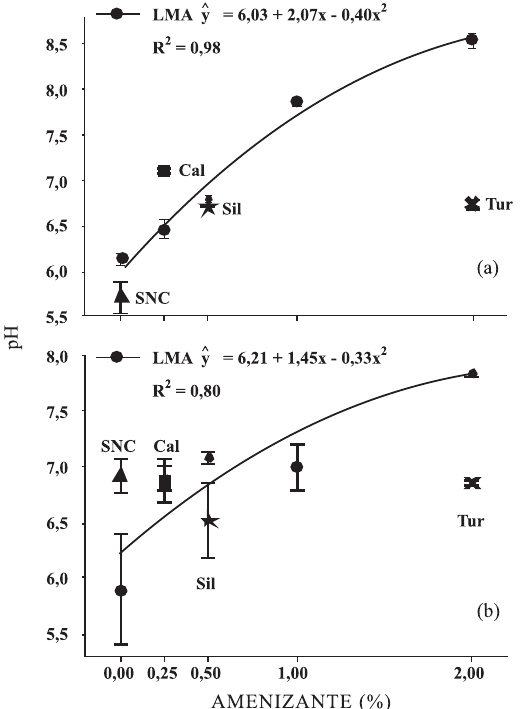
Figura 1. Valores médios de pH nos lixiviados do Neossolo Quartzarênico (a) e do Latossolo Vermelho (b) contaminados com Cd e Pb coletados no término do experimento. LMA: lama da mineração de Al, SNC: solo não- contaminado, Cal: calcário, Sil: silicato, e Tur: turfa.